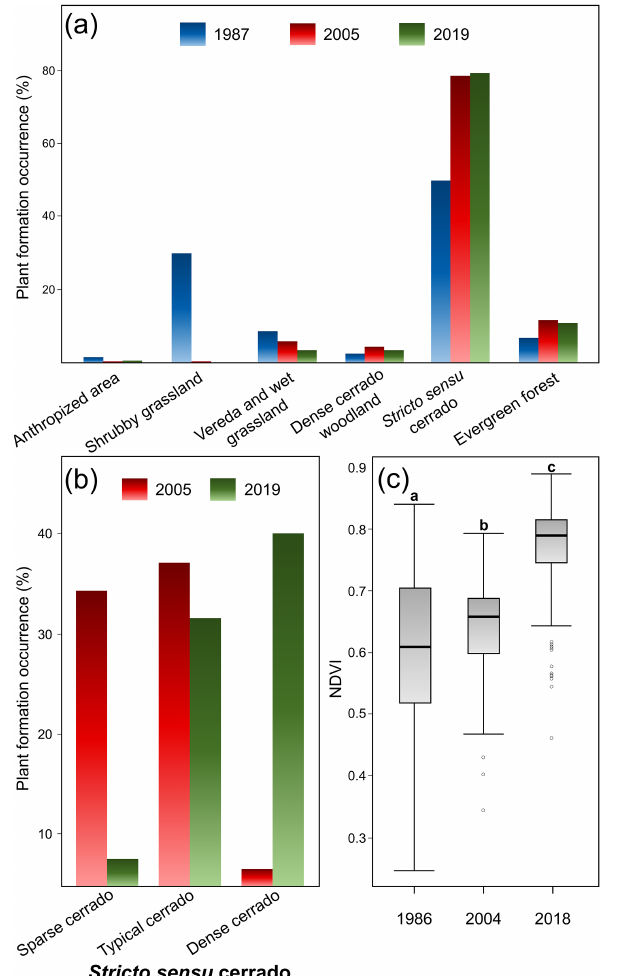
Figure 3. Vegetational changes in the PES over time. (a) Compar- ison of all plant formations showing their percentage of surface oc- cupied in 1987, 2005 and 2019; (b) the percentage of surface oc- cupation among stricto sensu cerrado categories in 2005 and 2019; and NDVI differences among 1986, 2004 and 2018 surveys. (c) Dif- ferent letters indicate significant statistical differences at 0.05